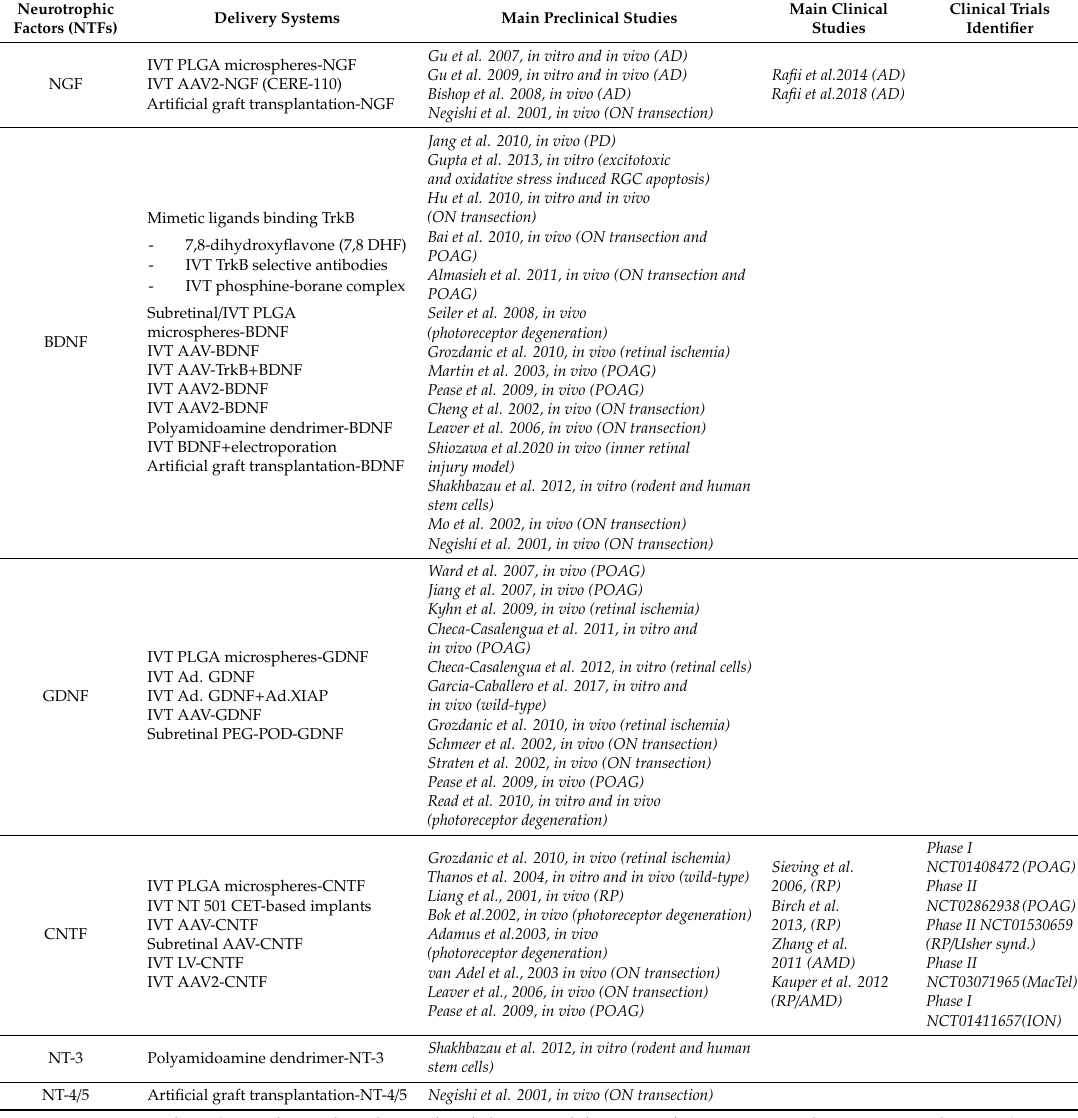
Table 1. Current status of delivery systems for Neurotrophic factors